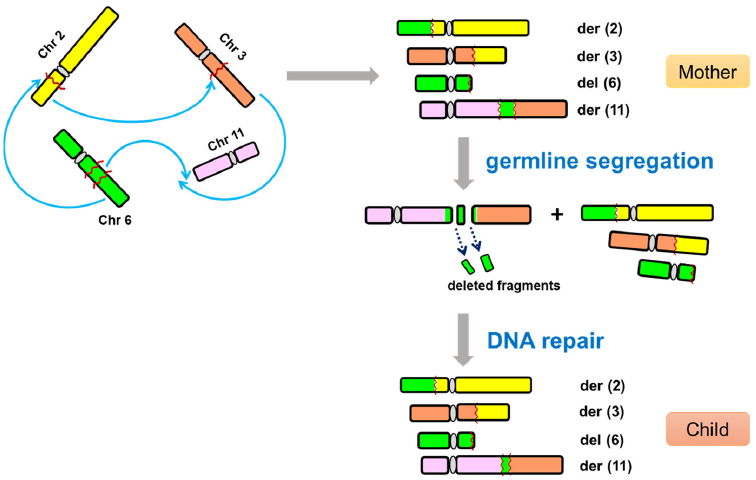
Figure 5. A proposed model of chromoanagenesis-related CCR in this study. This model illustrates a possible mechanism of the familial CCR through germline segregation and DNA repair to generate de novo deletions in the child.